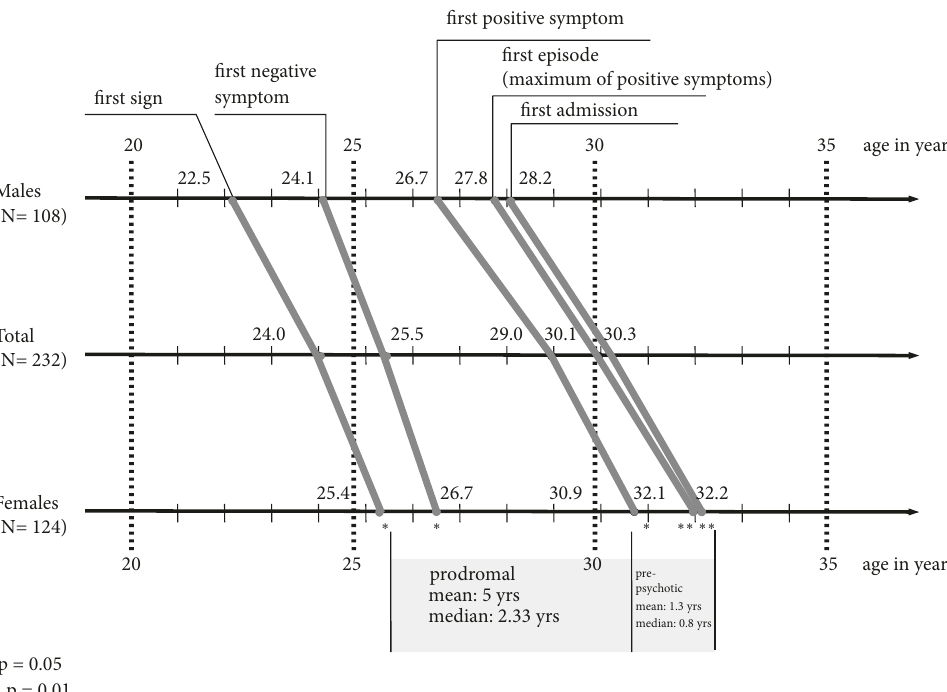
Figure1:Meanageby5definitionsofonsetuntilfirstadmission;ABCfirst-episodesampleofbroadly definedschizophrenia(N=232).Source: [8], modified.